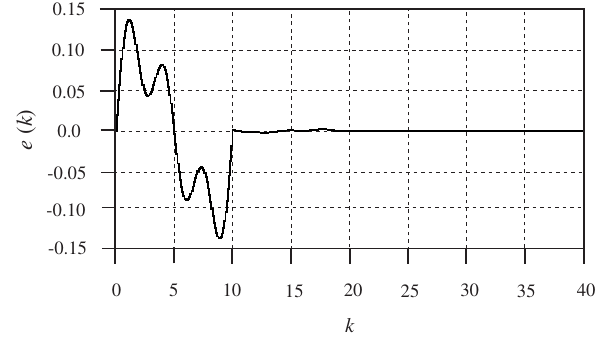
Figure 9. Tracking error with no